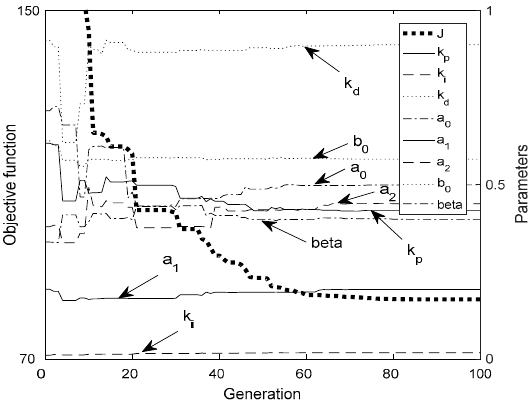
Figure 4. RCGA-based evolutionary tuning for PIPTD.